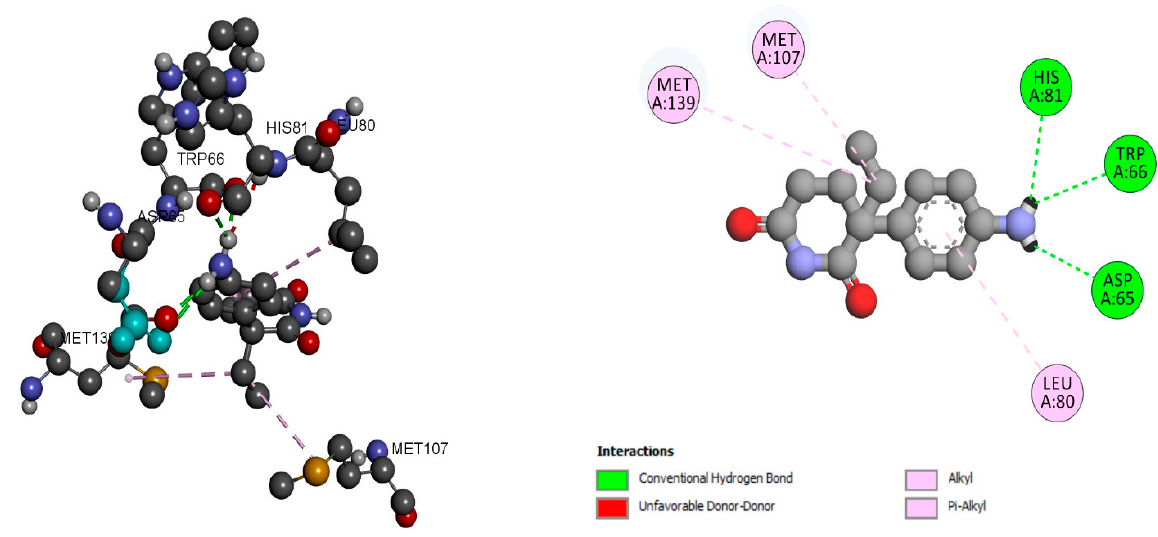
Figure 3. SHBG molecular interaction pattern with aminoglutethimide. Table 1. Molecular interaction analyses of SHBG with different